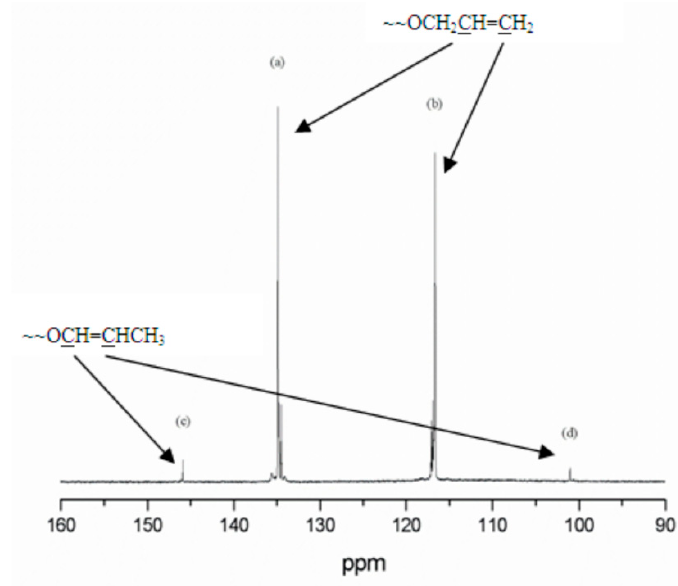
Figure 11. Signals of allyloxy ( a , b ) and cis -propenyloxy ( c , d ) groups observed in the unsaturated region of the 13 C NMR spectrum of PAGE / PBO / PAGE copolyether-diol